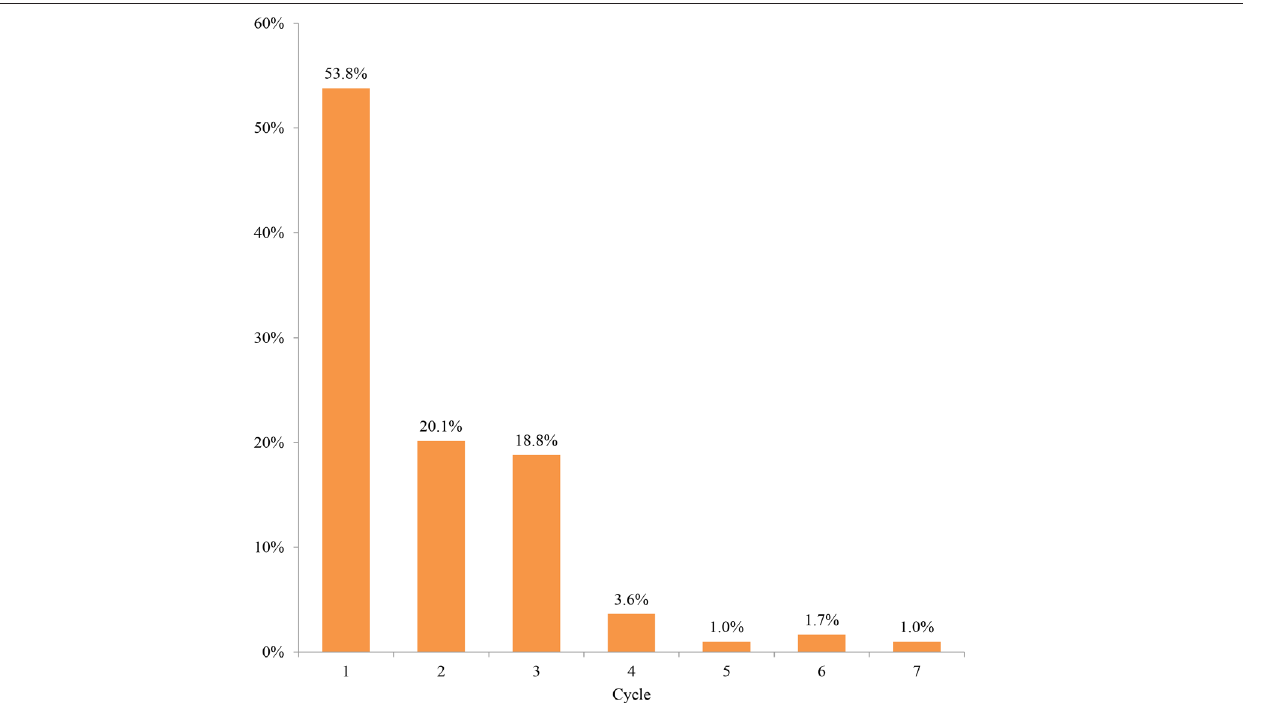
Figure 8. Treatment Cycles of Platinum Rechallenge Treatment Regimens for Platinum-Refractory Patients